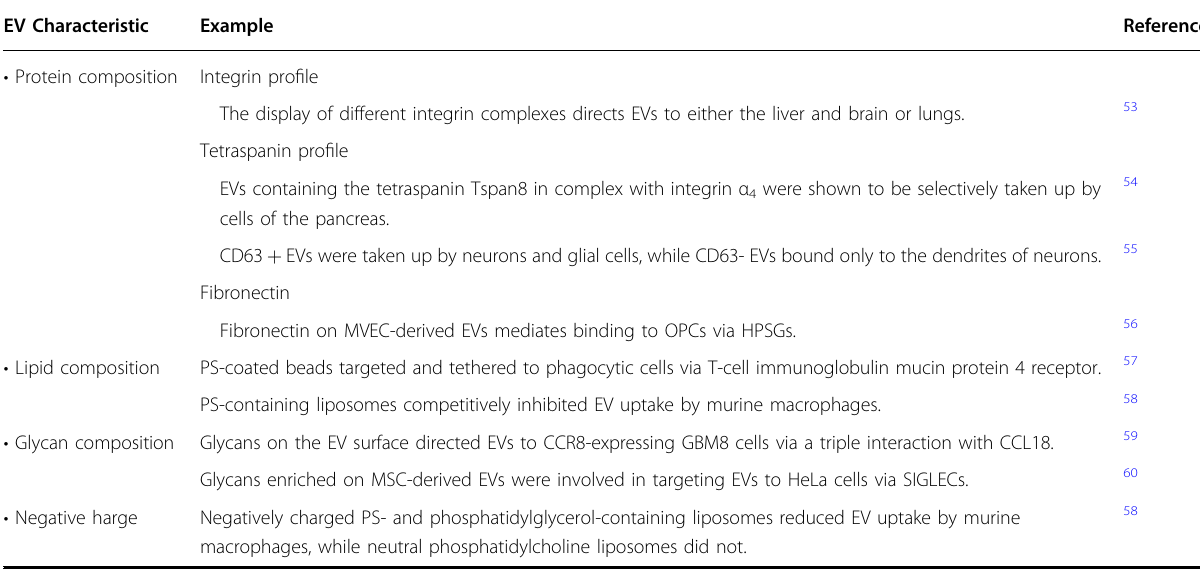
Table 1 An overview of natural EV features that in fl uence targeting EV